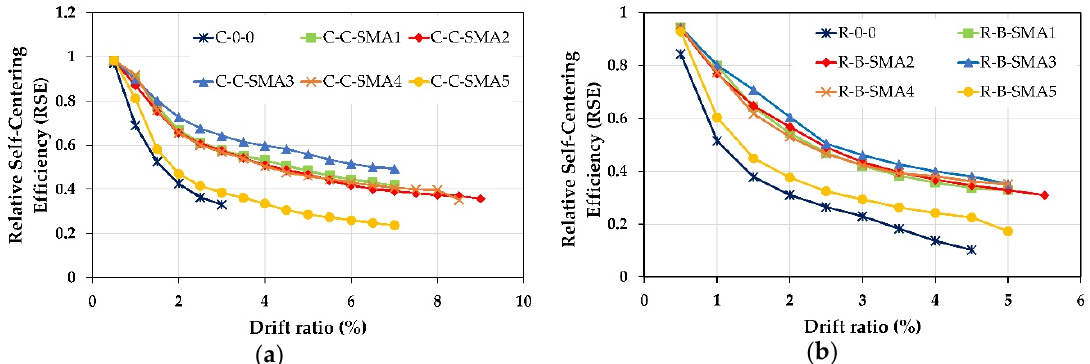
Figure 15. Relative Self Centering Efficiency versus the drift ratio: ( a ) Columns of Group1; ( b ) columns of Group2.